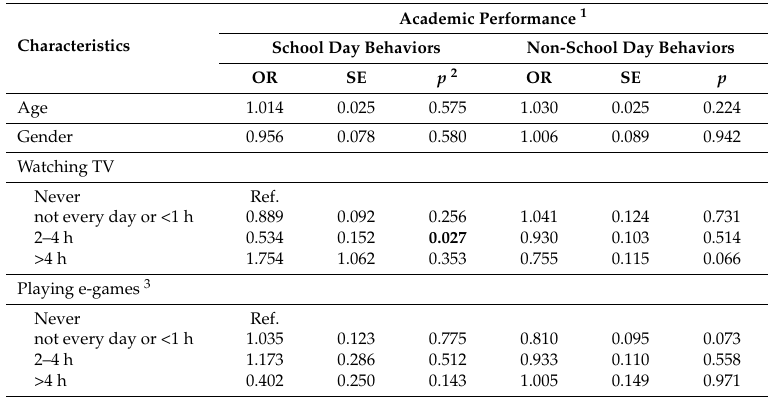
Table 2. The relation of academic performance and screen time components ( n =